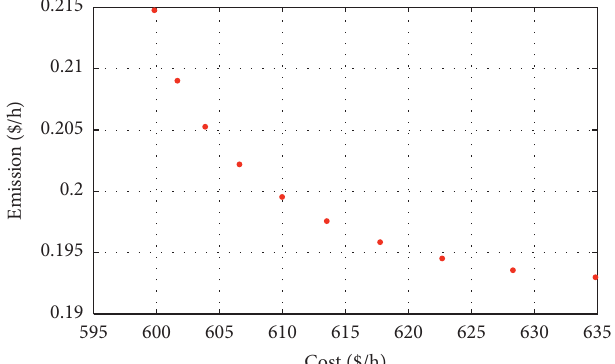
Figure 10: Compromising 10 alternatives from the Pareto set.